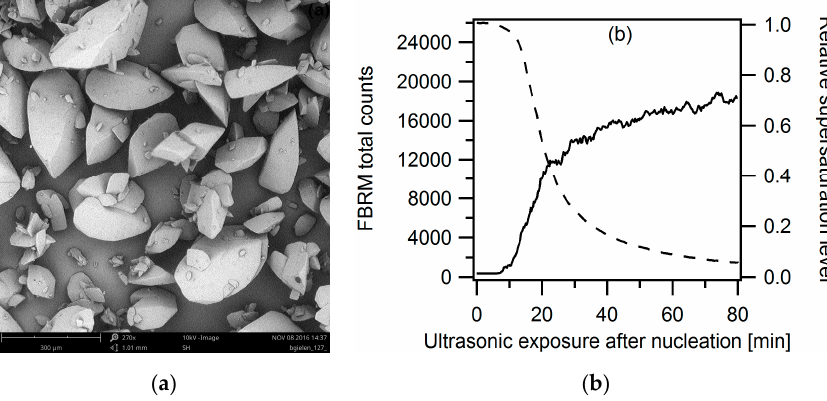
Figure 7 . Evaluation of agglomeration during spontaneous crystallization at 57 °C ( C 0 / C sat = 5.28), Figure 7. Evaluation of agglomeration during spontaneous crystallization at 57 ◦ C ( C 0 / C sat = 5.28), leading to fast crystal generation. ( a ) SEM-image (Magnification: 270×, 300 µm scale bar) showing the leading to fast crystal generation. ( a ) SEM-image (Magnification: 270 × , 300 µ m scale bar) showing predominant presence of mono-crystals. ( b ) The FBRM and IR trend allow tracking the total chord the predominant presence of mono-crystals; ( b ) The FBRM and IR trend allow tracking the total chord count and solute concentration during the experiment. count and solute concentration during the